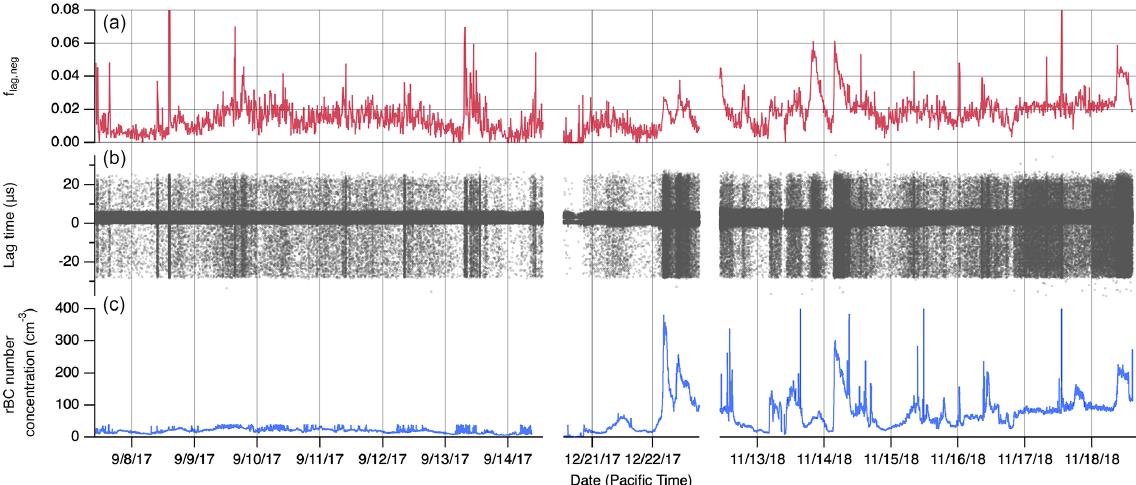
Figure 6. Panel (a) shows the 10min mean time series for the number fraction of rBC particles with negative lag times ( f lag , neg ). The threshold for negative lag times was set to − 1 . 25µs to account for uncertainties in the lag-time determination (Sedlacek et al., 2012). Panel (b) shows the time series of lag-time values for each individual particle, corresponding to individual dots on the graph. Panel (c) shows the 1min mean rBC number concentration for reference. Dates on the x axis are given in the following format: month/day/year.